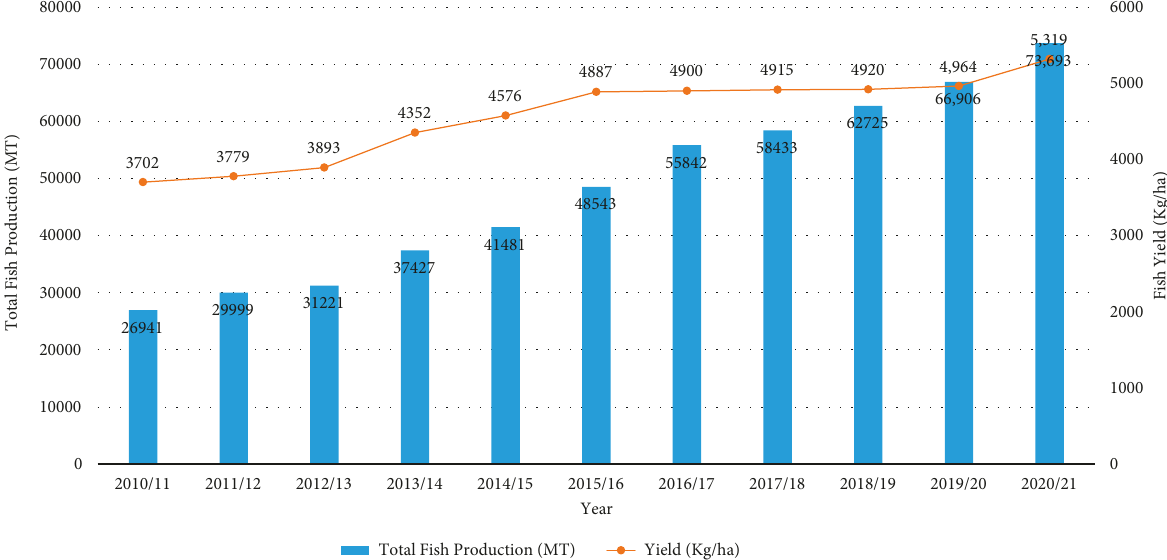
Figure 5: Total pond fish production (Mt) and fish yield (Kg/ha) from the fiscal year 2010/11 to 2020/21 in Nepal, source: [27, 28].